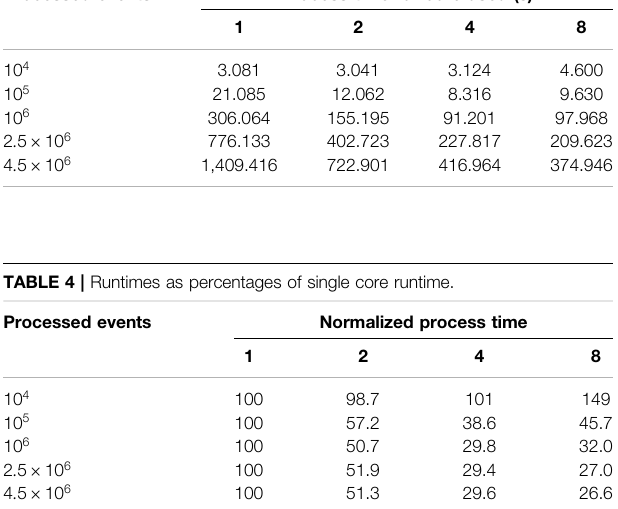
TABLE 3 | Variation of run times with changing number of threads. Processed